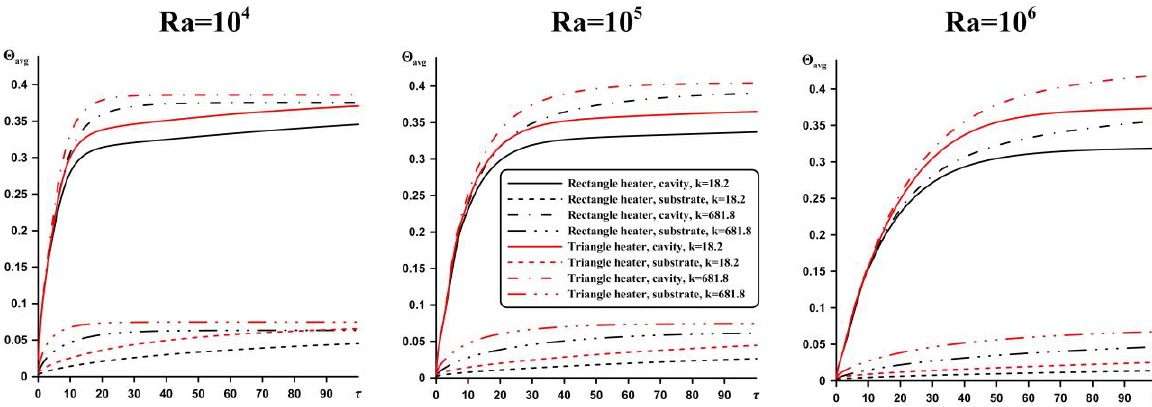
Figure 8. Time evolution of the average temperature in the cavity and the substrate depending on the heat source shape, k and Ra.